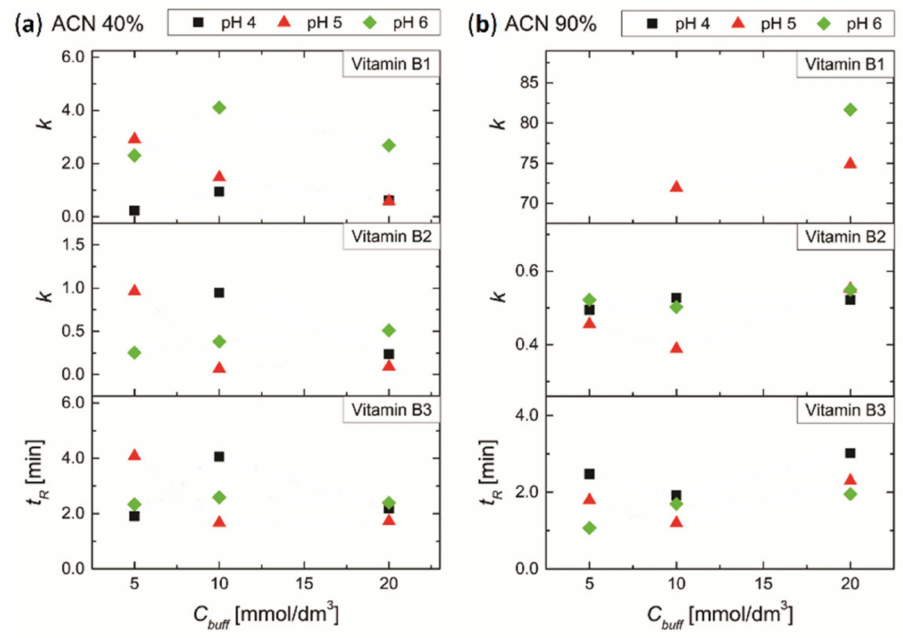
Figure 10. Effect of buffer pH and concentration on retention of vitamins in column A (Acclaim™ Mixed–Mode HILIC 1) with: ( a ) 90% and ( b ) 40% content of acetonitrile in mobile